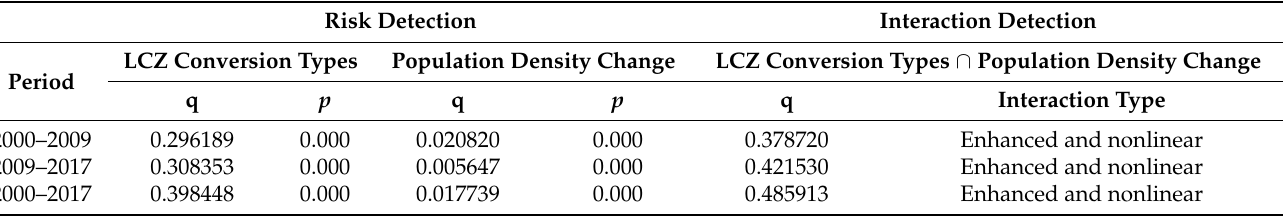
Table 7. Factor and interaction detection results (dependent factor: sUHI intensity change; independent factors: LCZ conversion types and population density